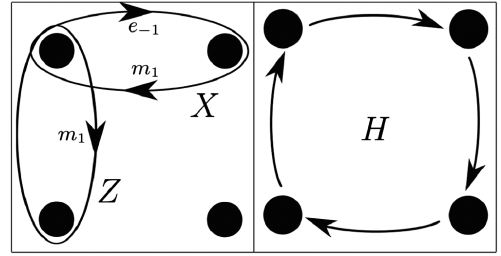
FIG. 5. All generators of the single-qudit Clifford group can be performed by braiding quasi-particles. The four circles corre- spond to the four parafermion modes which are used to store one logical qudit. The left part of the figure illustrates how to perform the logical operators X and Z by braiding the Abelian excitations of the D ð Z 4 Þ model around the parafermions. The right part demonstrates a logical Hadamard gate H , which is performed by braiding the parafermion modes themselves.